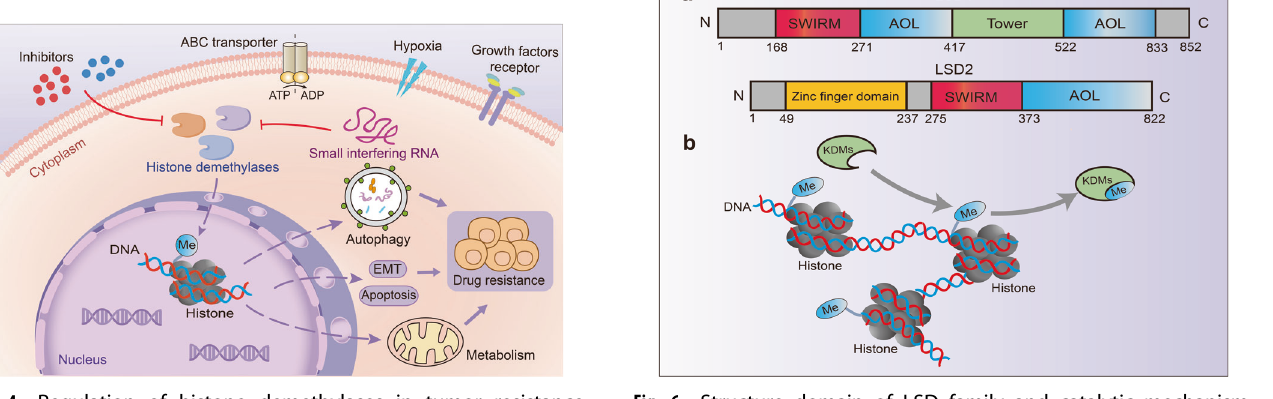
Fig. 4 Regulation of histone demethylases in tumor resistance. Histone demethylases can contribute to the development of drug resistance by regulating gene transcription, promoting autophagy, reducing apoptosis, affecting cellular metabolic processes, and promoting epithelial-mesenchymal transition. Conversely, targeting histone demethylases by inhibitors or small interfering RNAs can reverse drug resistance